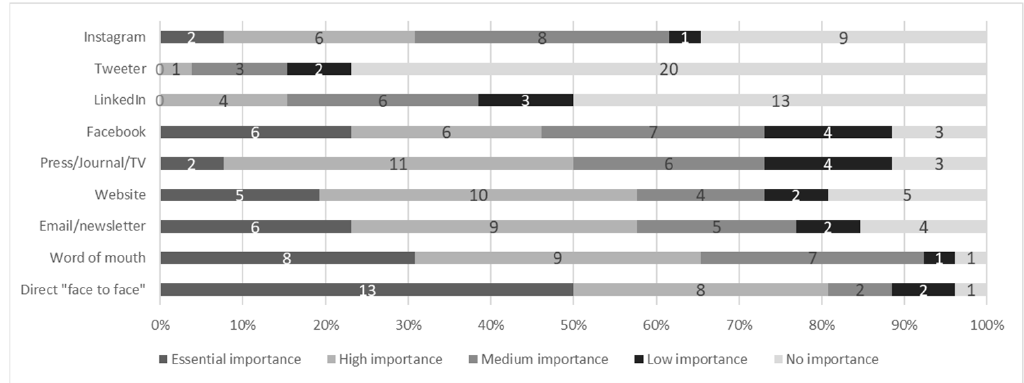
Figure 10. Levels of importance of different communication channels.